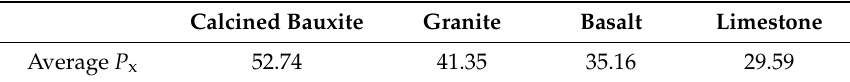
Table 8. Average P x values for the di ff erent aggregates.